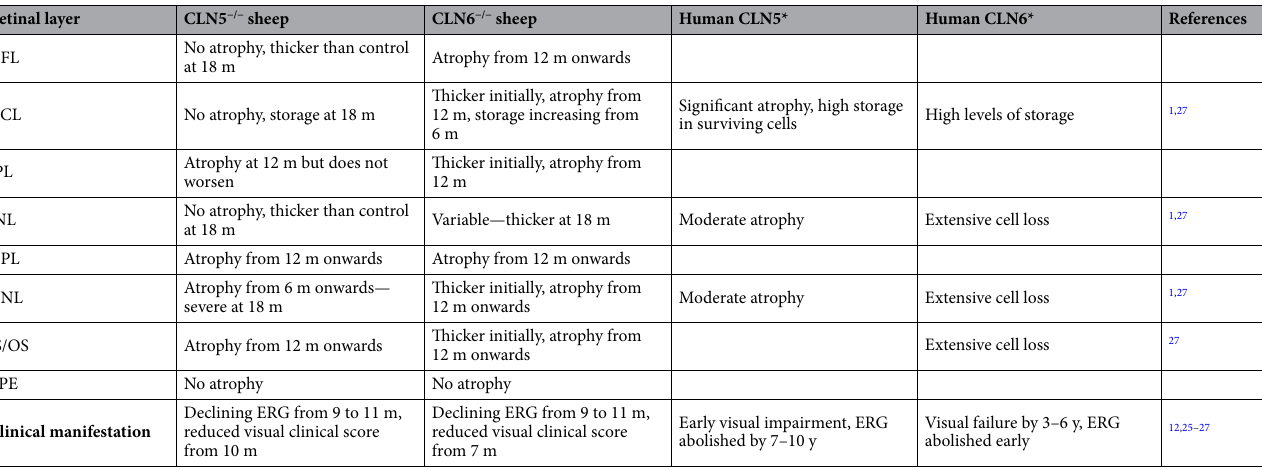
Table 1. Comparison of retinal disease in CLN5 and CLN6 sheep and human patients. *Data refers to cases of late infantile onset NCL. ERG; electroretinography, m; months, y; years, NFL; nerve fibre layer, GCL;